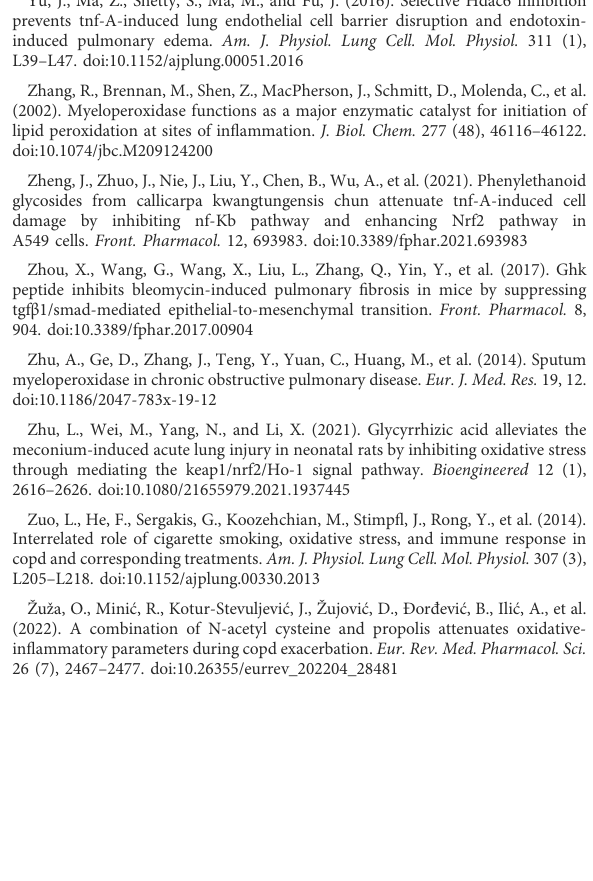
Tabassum, R., Vaibhav, K., Shrivastava, P., Khan, A., Ahmed, M., Ashafaq, M., et al. (2015). Perillyl alcohol improves functional and histological outcomes